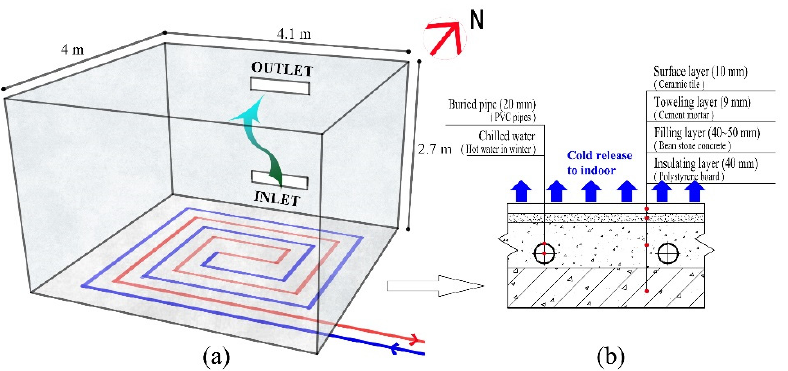
Figure 1. Numerical simulation diagram of the TRNSYS.